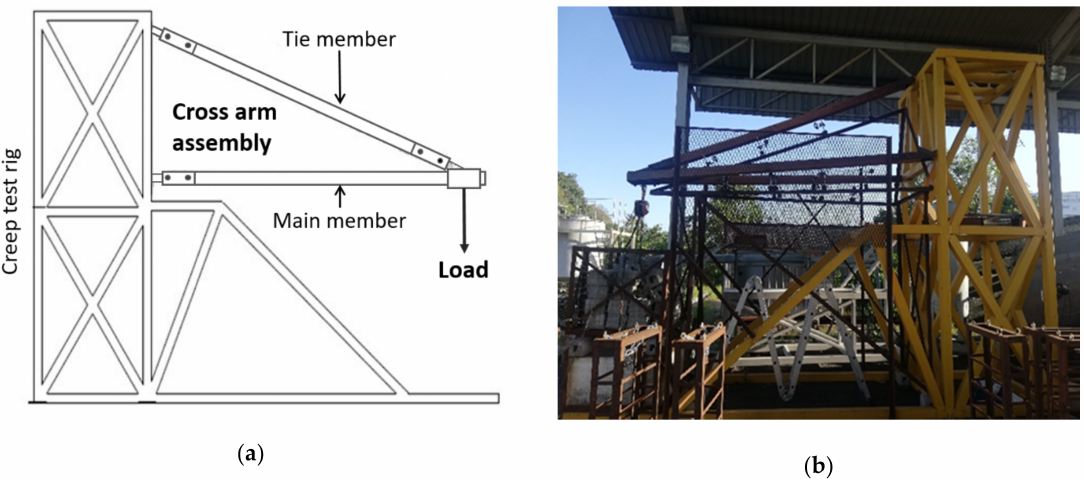
Figure 4. ( a ) Schematic diagram and ( b ) actual image of PGFRPC cross-arm used in the creep test